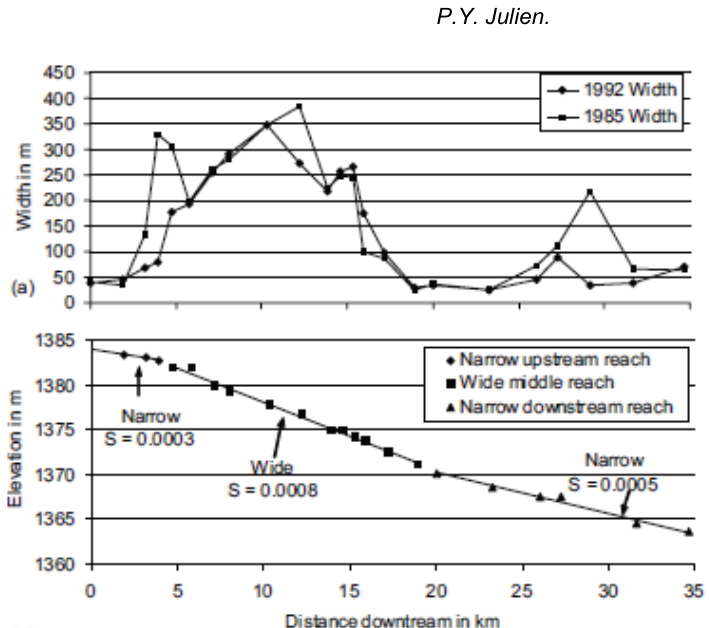
Fig. 6 Changes in channel slope as a result of channel width changes on the Rio Grande (Leon et al ., 2009).